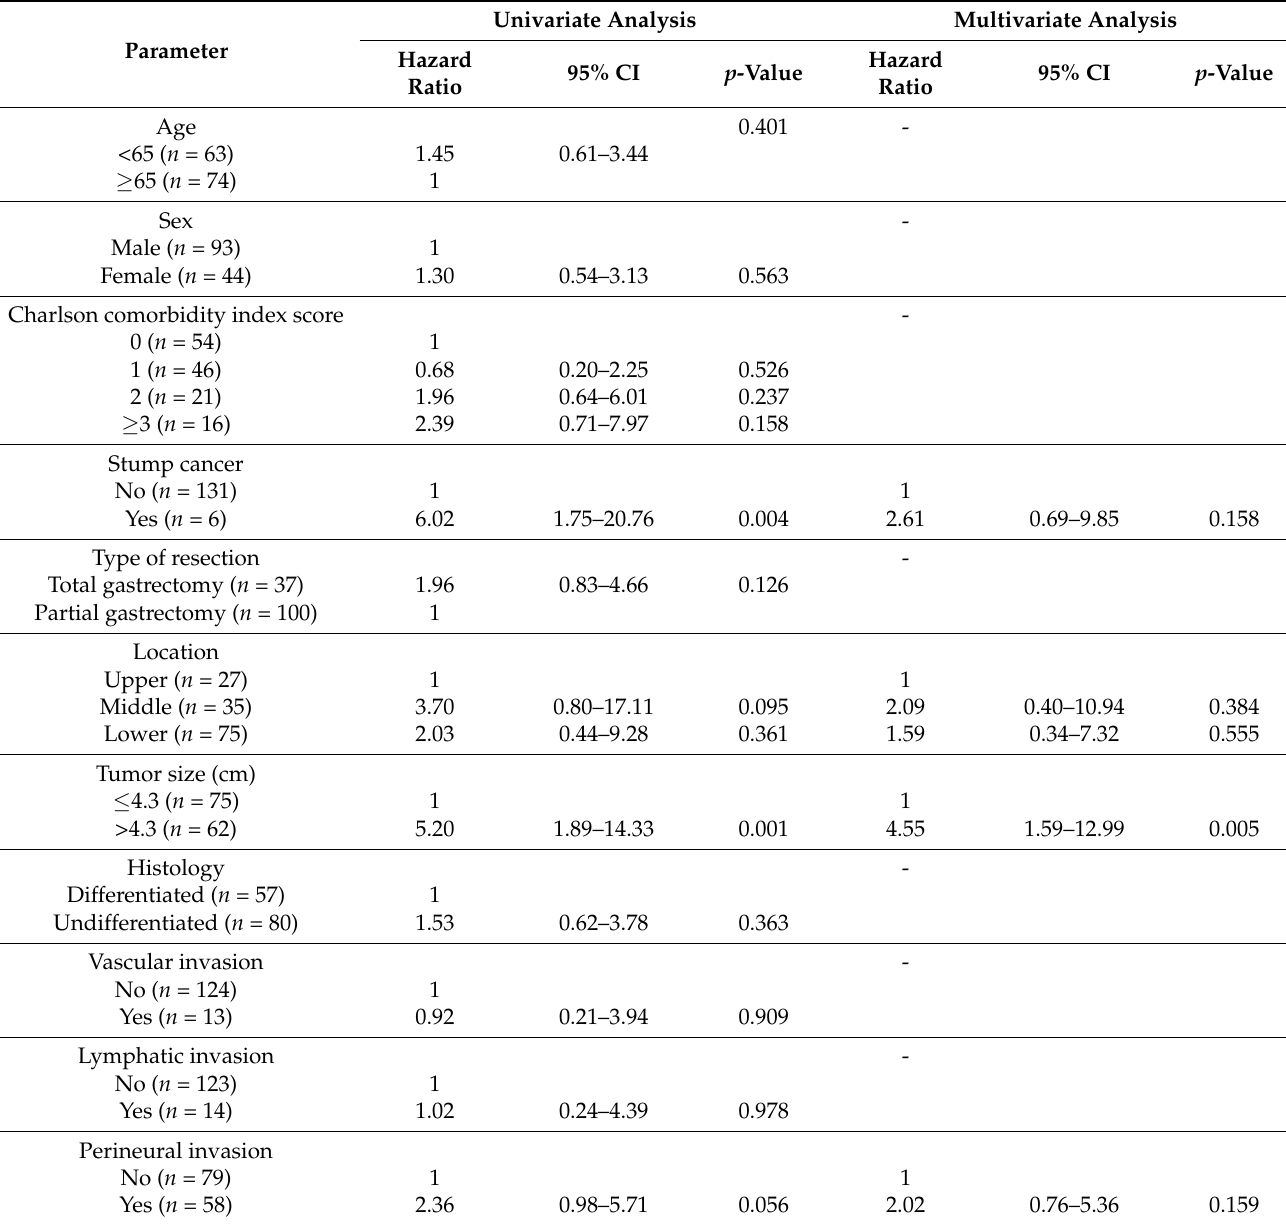
Table 3. Univariate and multivariate analyses of prognostic factors for disease-free